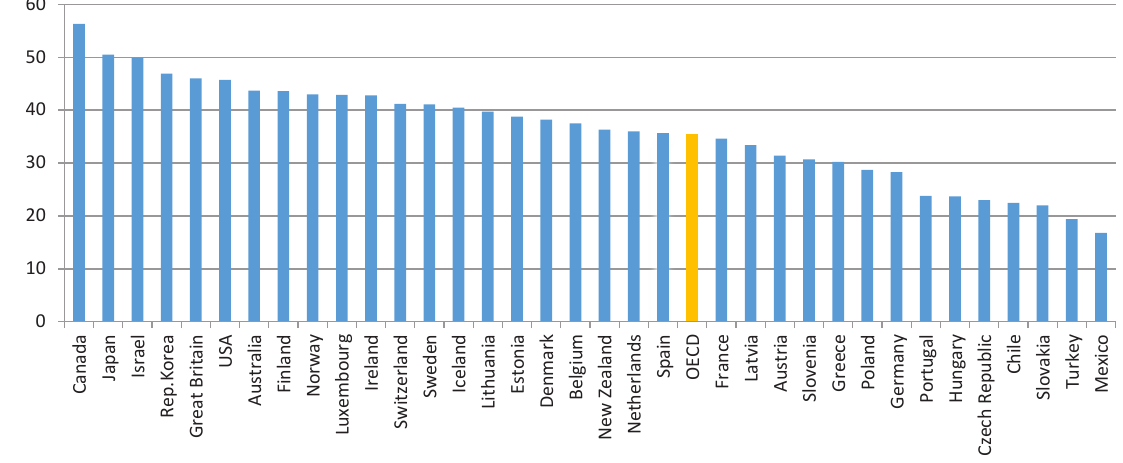
Figure 3. Share of people with higher education in OECD countries (2016),